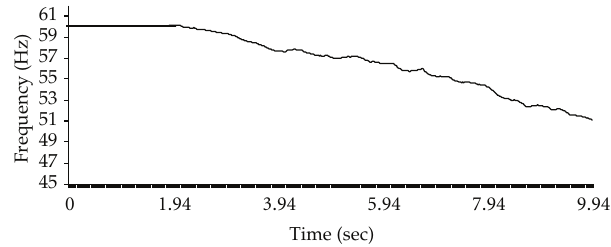
Figure 13: The average bus frequency decline due to a fault at Line